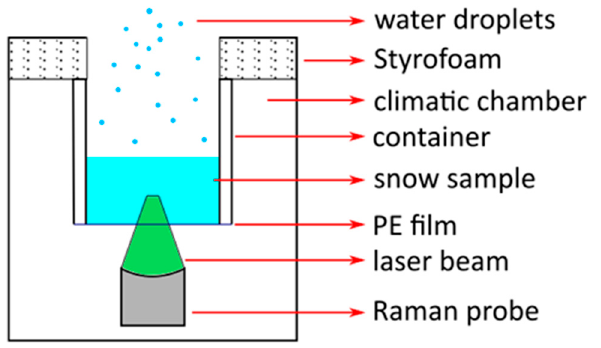
Figure 5. Schematic of the Raman probe disposition with respect to the snow sample. The green triangular area represents the laser focus position within the snow volume.